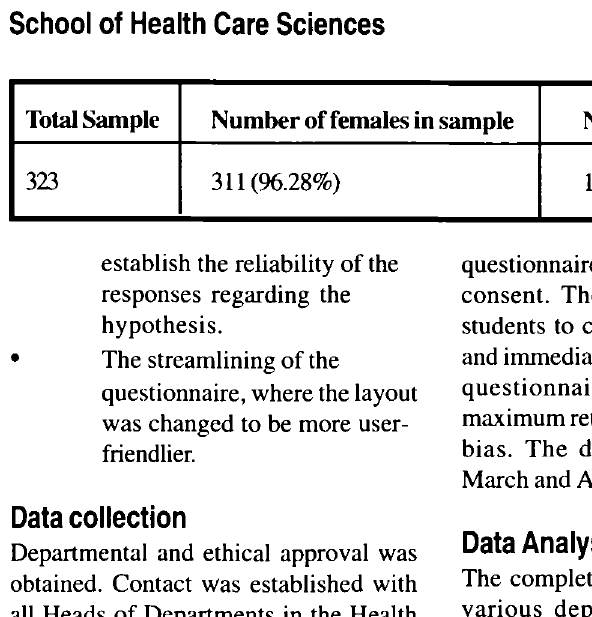
TABLE II: Distribution of male and female students enrolled at the School of Health Care